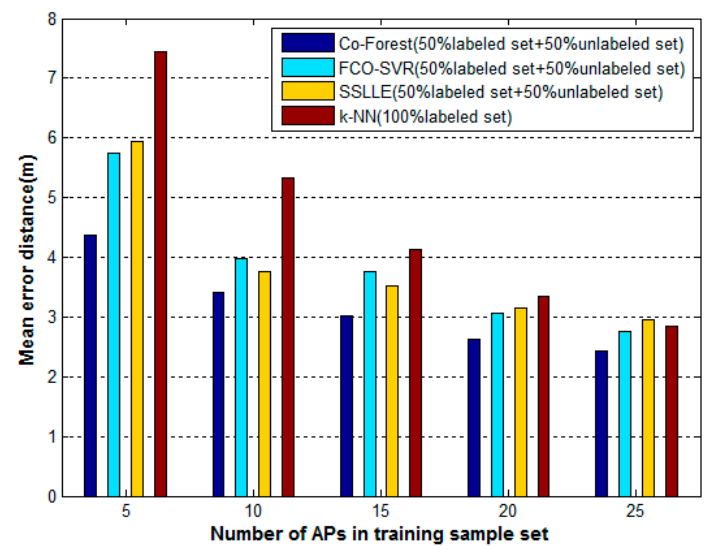
Figure 9. The change in mean error distances of algorithms with the number of APs in the training sample